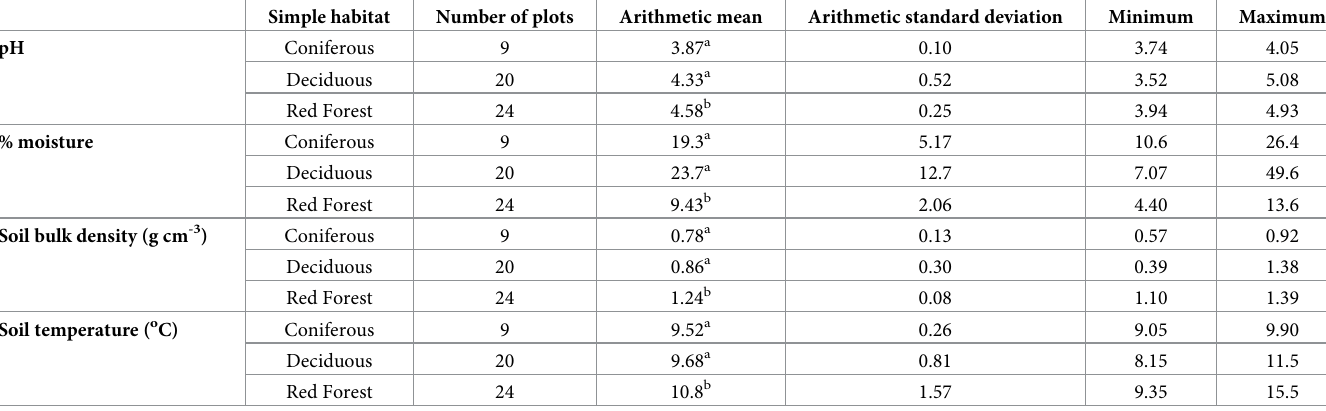
Table 4. Soil pH, percentage moisture, bulk density and temperature summarised by simple habitat. Simple